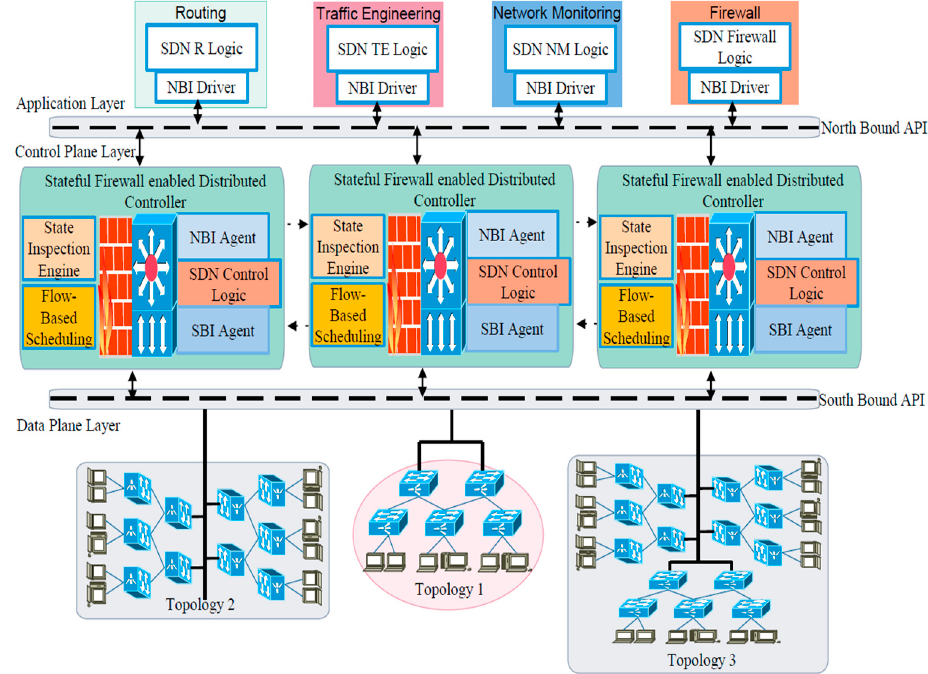
Figure 5. Stateful firewall enabled three distributed SDN controller.